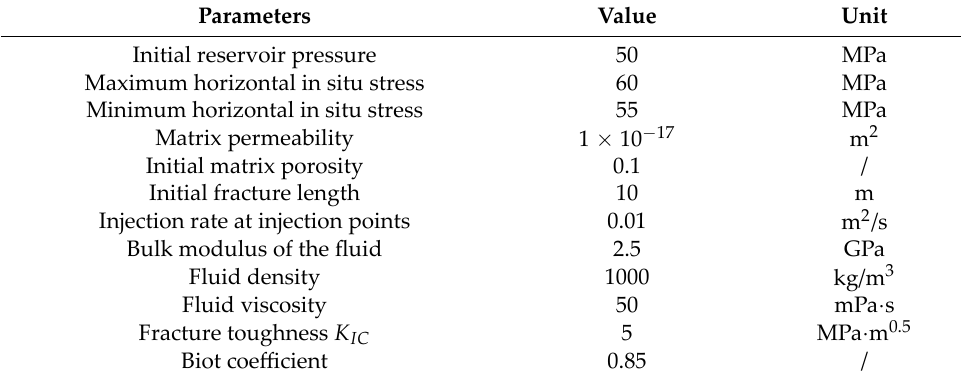
Table 4. Parameters for case study.